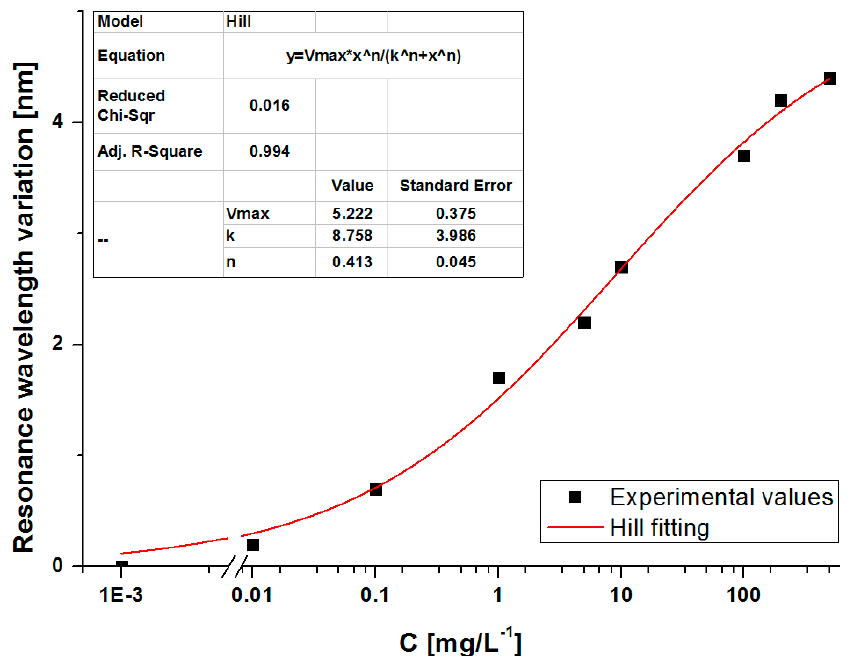
Figure 5. Absolute values of resonance wavelength shift versus the concentration of analyte and the fitting of the data by Hill equation. Inset: Hill parameters.